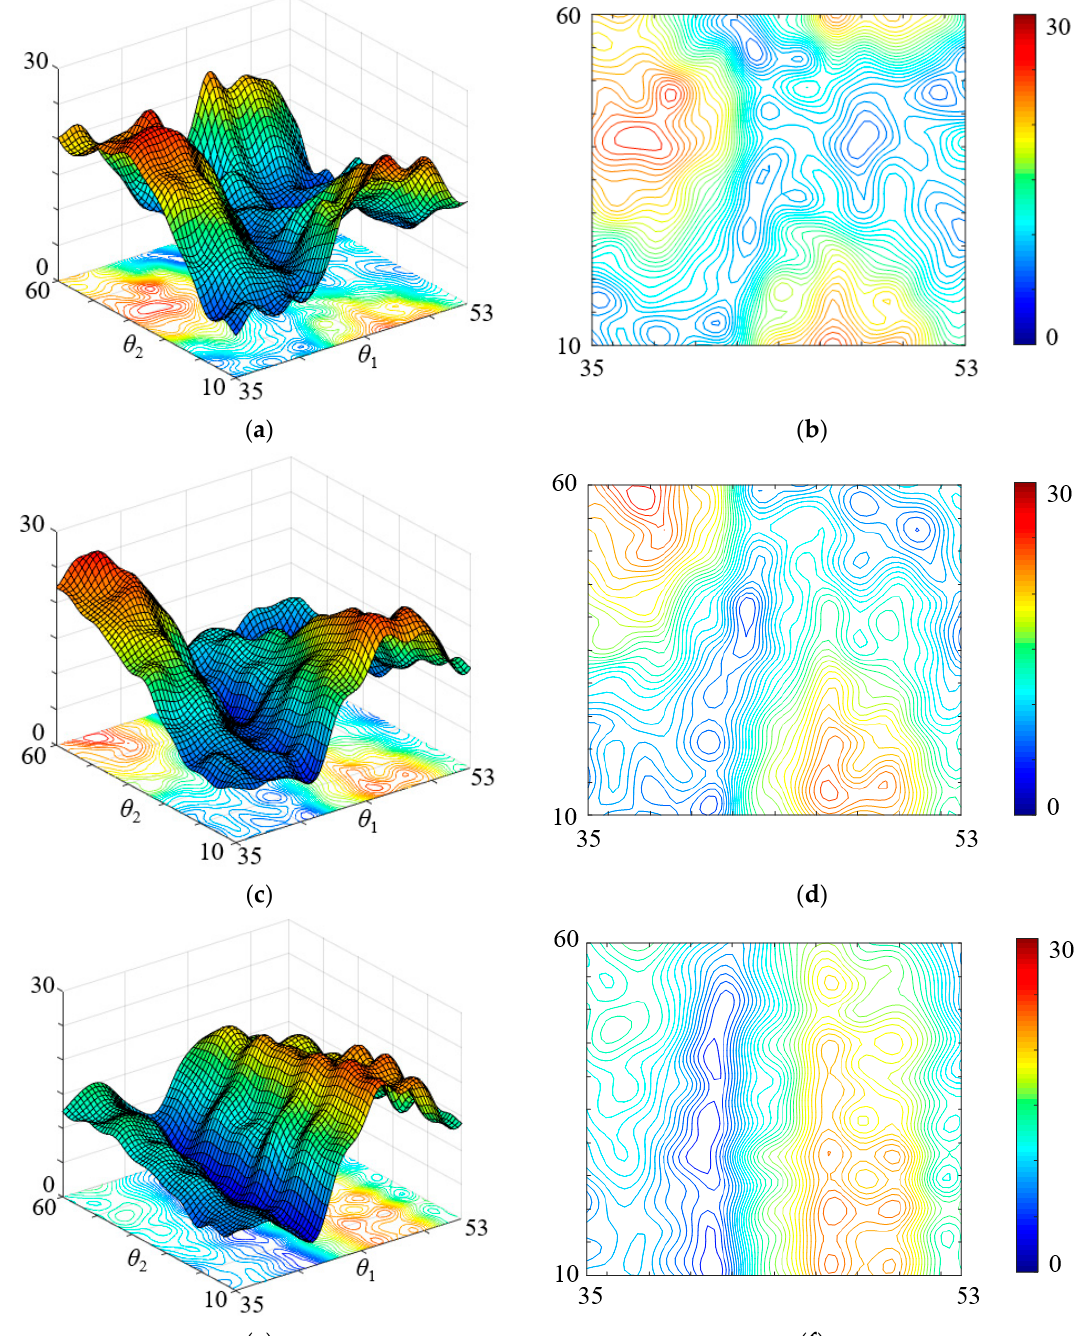
Figure 9. Torque ripple for design variable θ 1 and θ 2 : ( a ) 3-Dimensional plot when length is 13 mm; ( b ) Contour plot when length is 13 mm; ( c ) 3-Dimensional plot when length is 15.5 mm; ( d ) Contour plot when length is 15.5 mm; ( e ) 3-Dimensional plot when length is 18 mm; ( f ) Contour plot when length is 18 mm. Table 5. Variables of initial and optimal models.